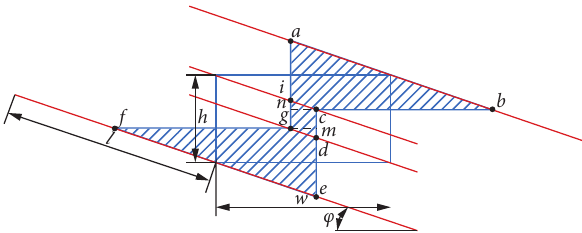
Figure 7: Traces with both ends censored, l ≥ ( h /sin φ ) and φ ≥ tan − 1 ( h / w ) .